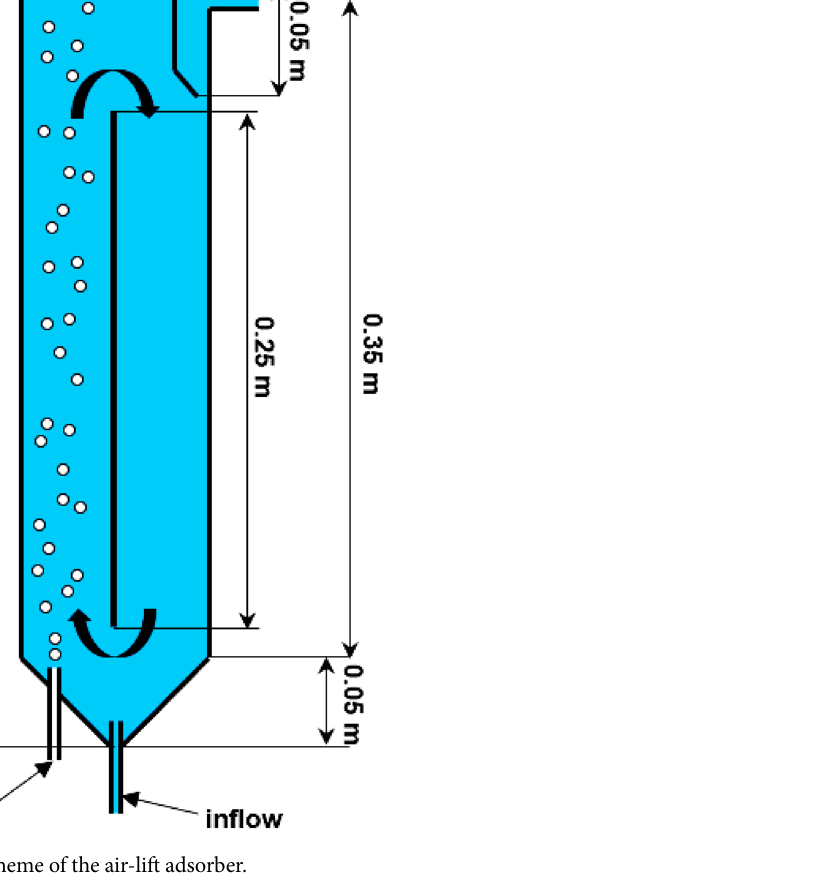
Figure 1. Scheme of the air-lift